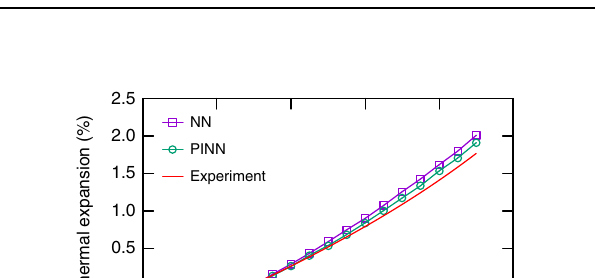
The potential predictions are compared with DFT calculations from the literature E 0 equilibriumcohesiveenergy, a 0 equilibriumlatticeparameter, B bulkmodulus, c ij elasticconstants, γ s surfaceenergy, E f v vacancyformationenergy, E m v vacancymigrationbarrier, E f I interstitialformation energy for the tetrahedral ( T d ) and octahedral ( O h ) positions and split dumbbell con fi gurations with different orientations, γ SF intrinsic stacking fault energy, γ us unstable stacking fault energy. All defect energies are statically relaxed unless otherwise indicated a Ref. 61 ; b ref. 62 ; c ref. 63 ; d ref. 64 ; e ref. 65 ; f ref. 66 ; g ref. 67 ; h ref. 68 ; i ref. 69 ; j ref. 70 *Unstable and fl ips to the 〈 100 〉 dumbbell orientation